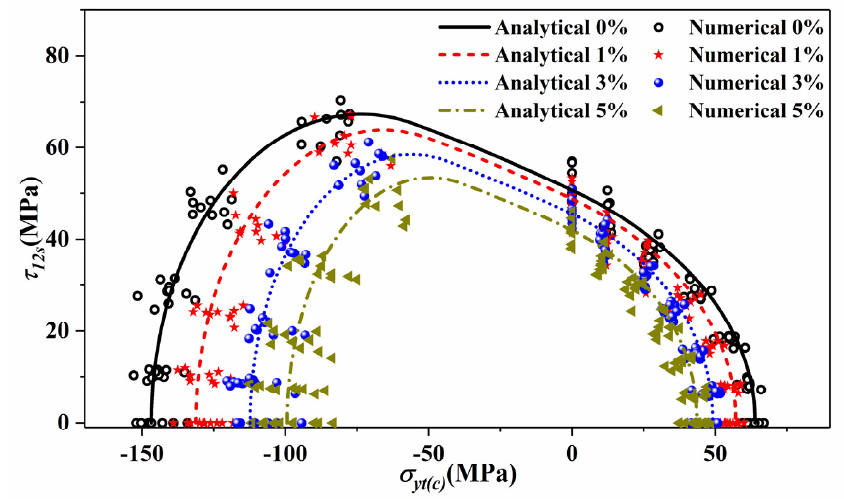
σ τ− stress space under different void